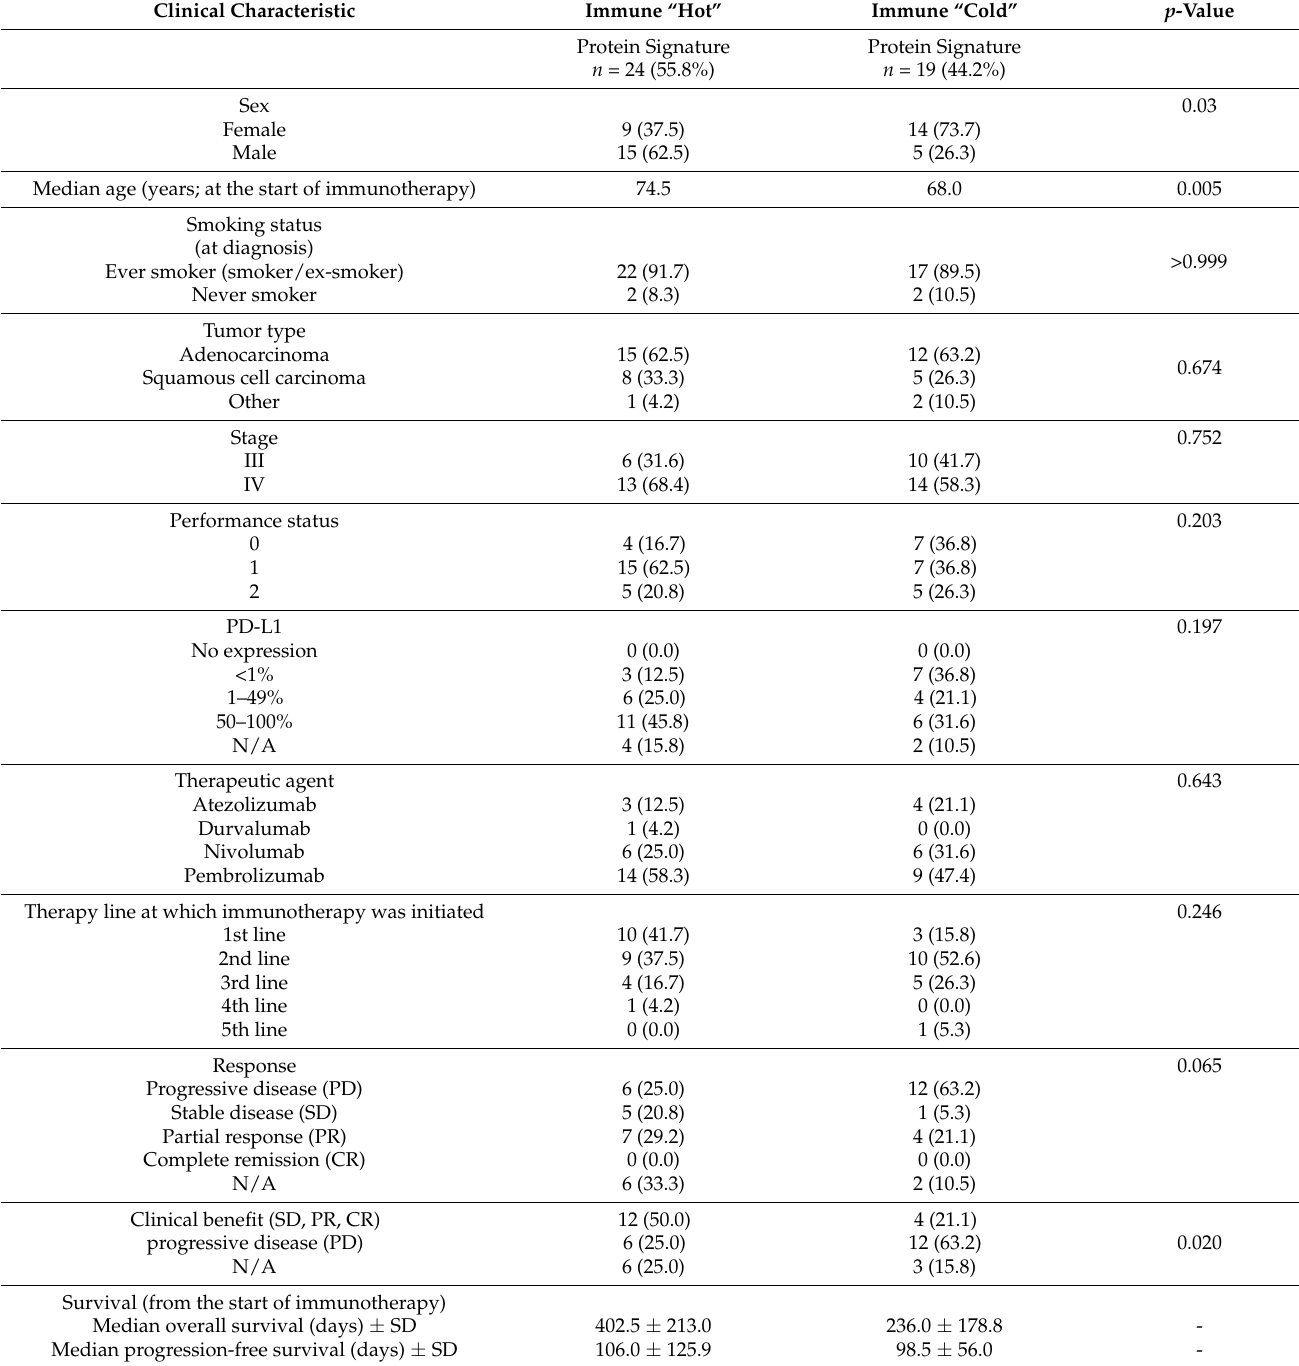
Table 2. Comparison of patients’ clinical characteristics between the T-cell activation-related plasma protein (22 proteins) signature (immune “hot” vs. immune “cold”) subgroups. p -values were obtained using Fisher’s exact, Mann-Whitney, or chi-square